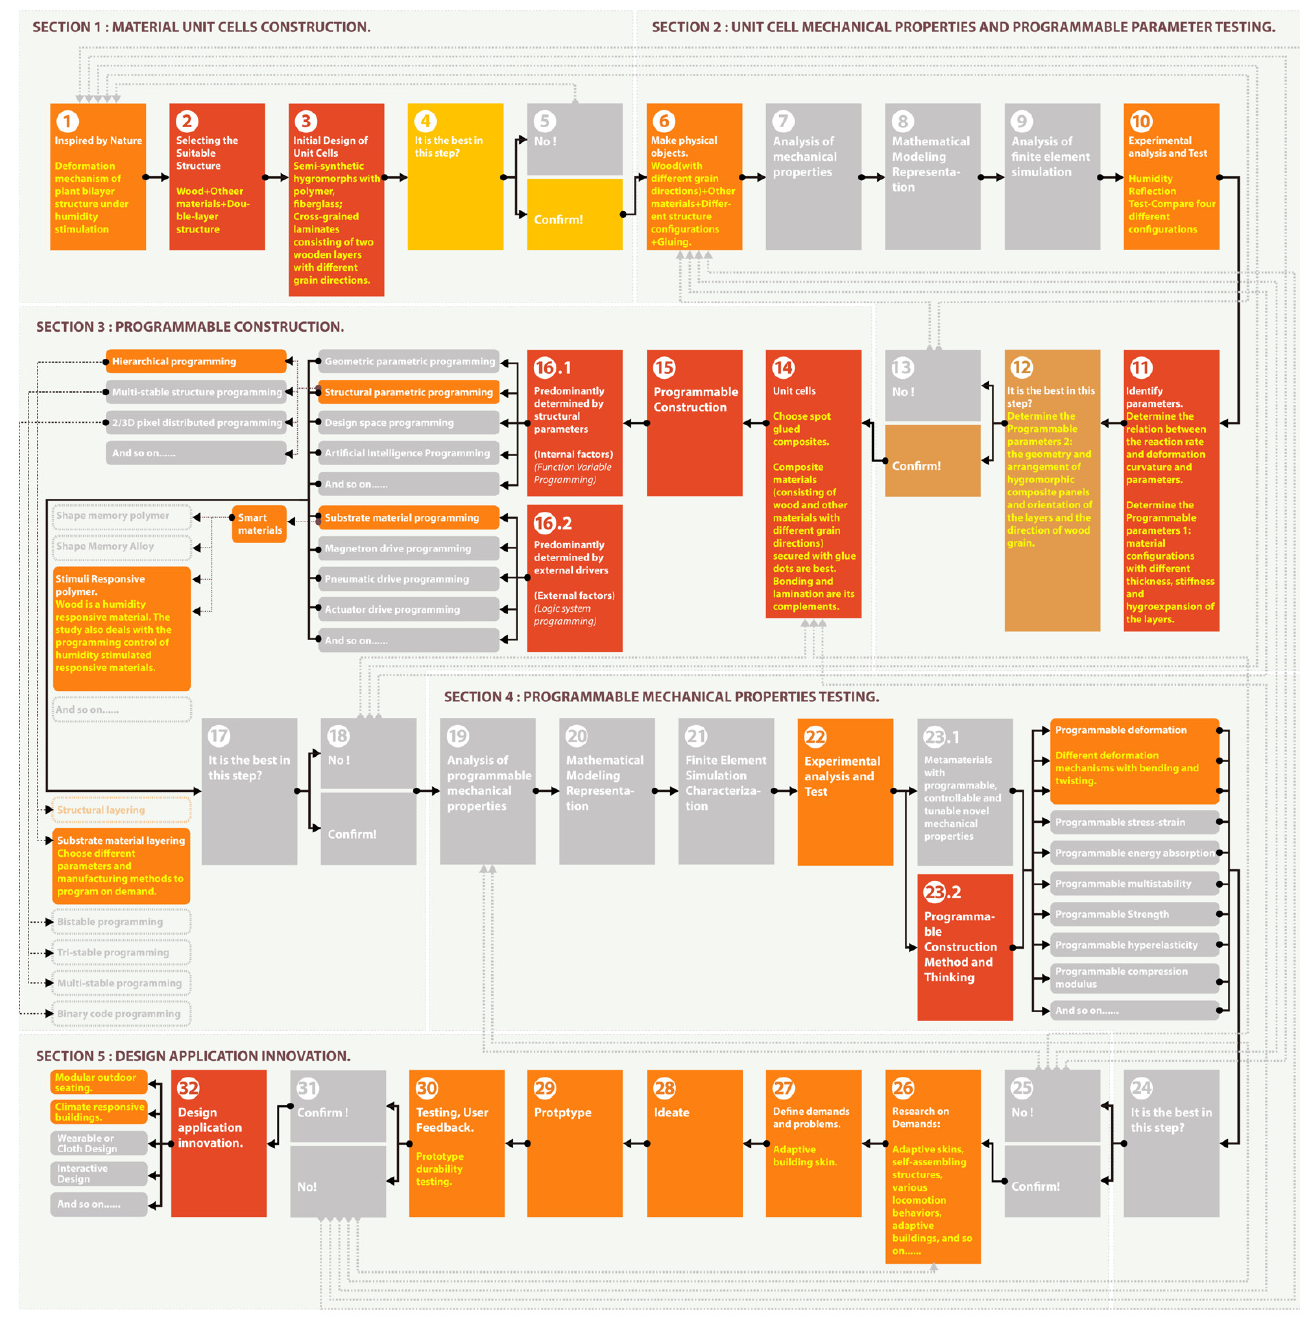
Figure 19. Combined with the IDMPMM process model, this research analyzes and sorts out the design method process of the responsive building skin design scheme (the colored part is the main part, and the gray part is the uninvolved steps).